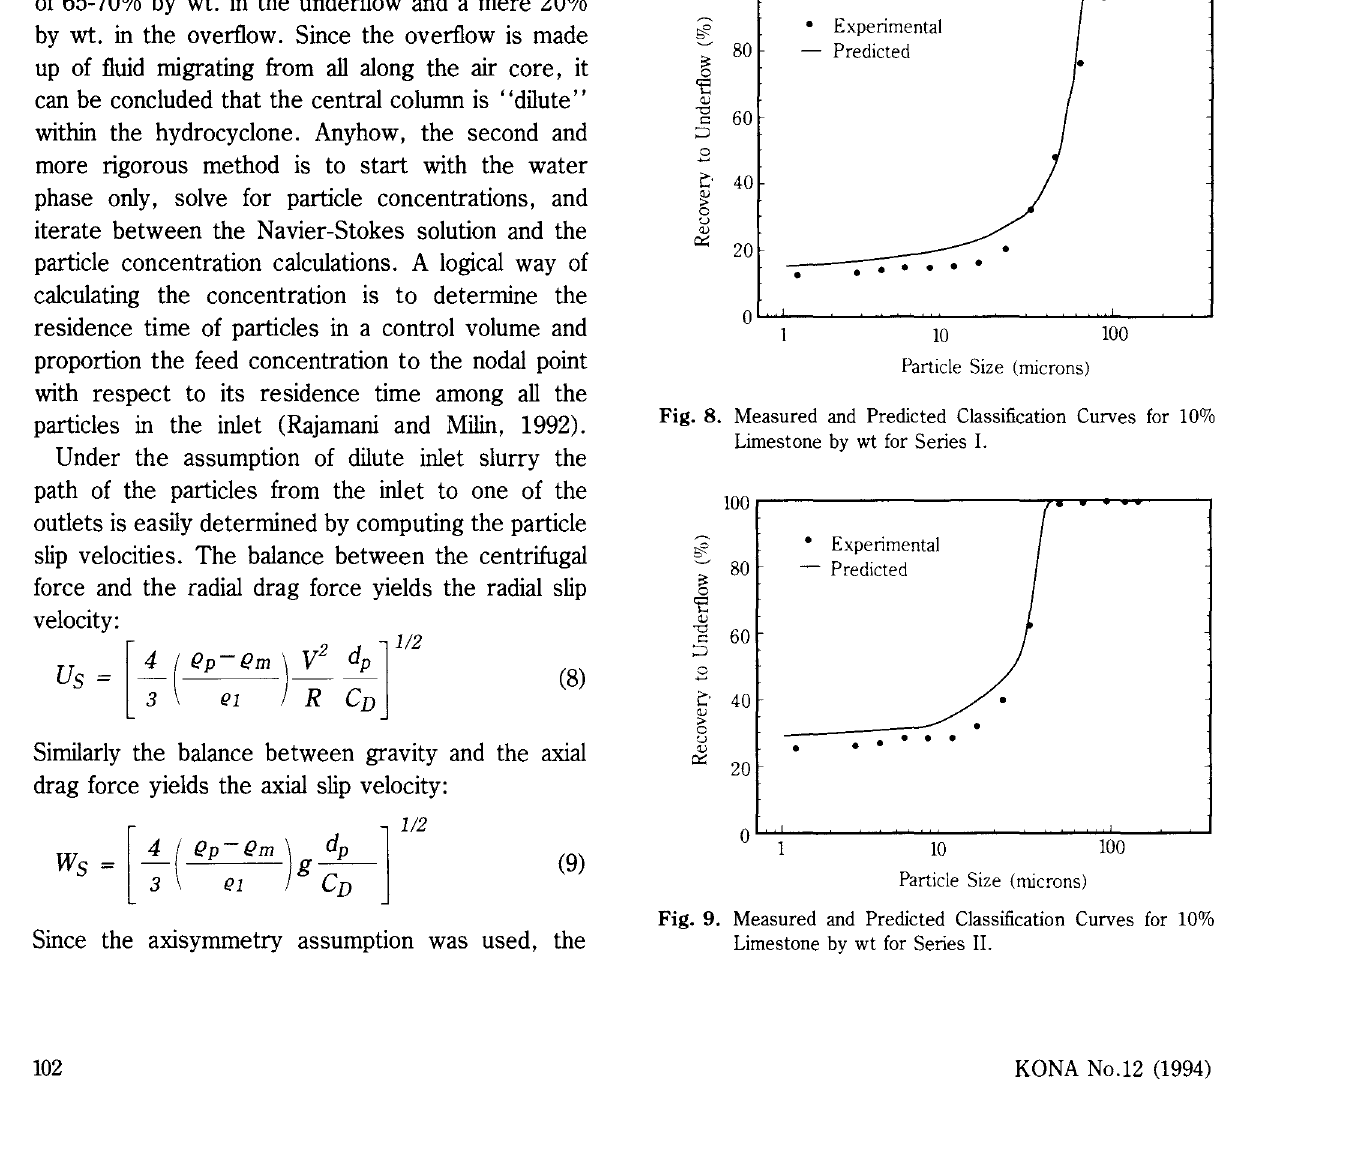
Fig. 8. Measured and Predicted Classification Curves for lOo/o Limestone by wt for Series I.